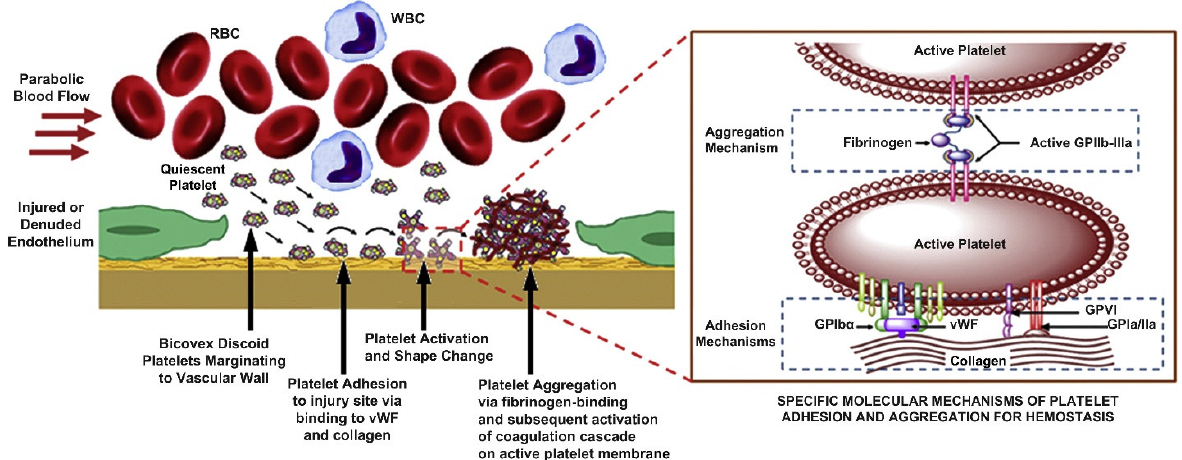
Figure 5. Physical and biological events in the hemostatic action of platelets. Reprinted/adapted with permission from Ref. [35]. 2013, Elsevier.